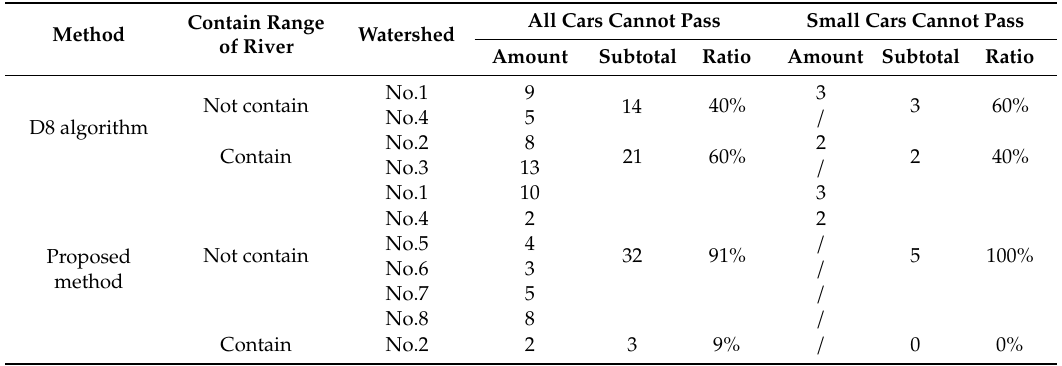
Table 6. Statistical information of four kinds of watershed delimitations derived by the corresponding design rainfall